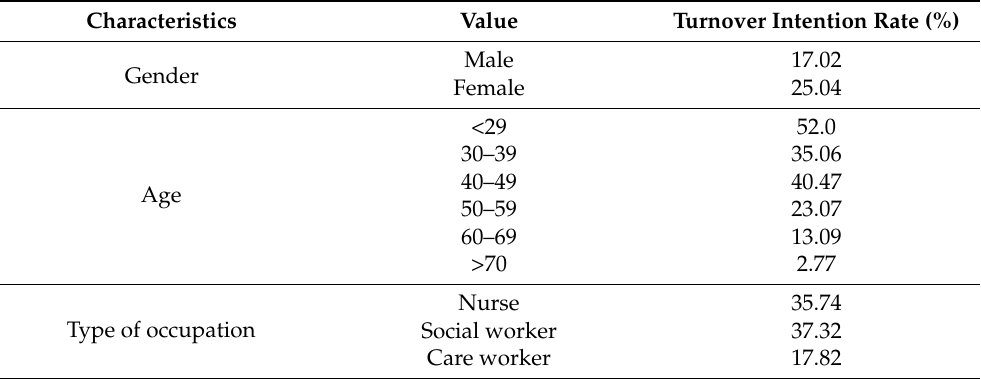
Table 3. The proportion of turnover intention based on characteristics of the group with experience of violence ( n = 3541).